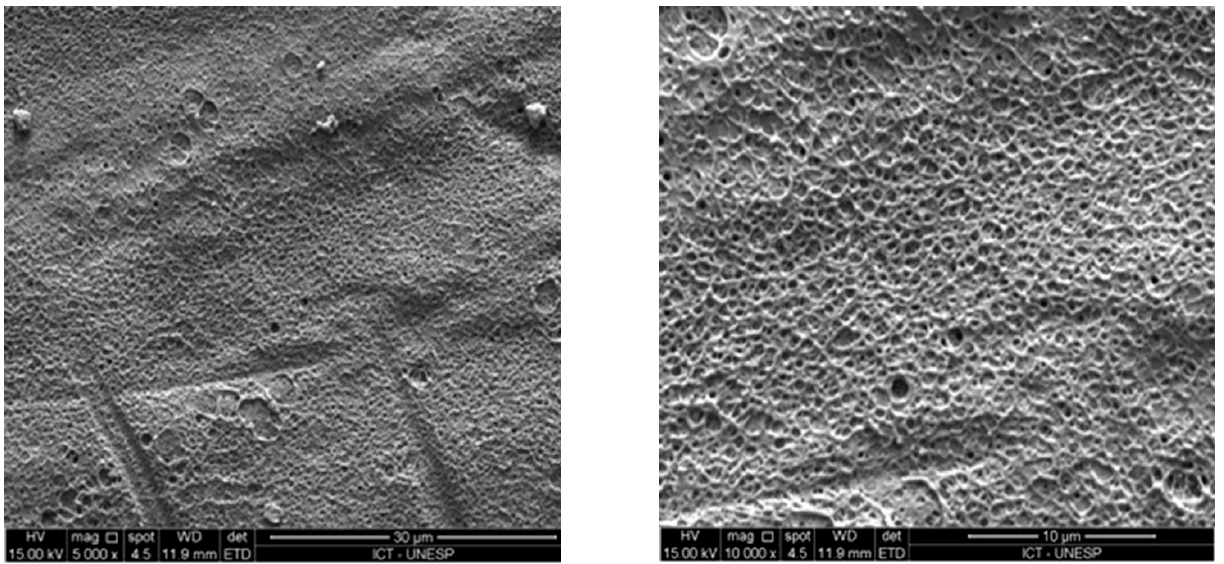
Figure 7. Sulfuric acid group (SA5). Surface etched with 98% sulfuric acid for 5 s, forming three-dimensional pores. It is noted that there is the presence of even deeper grooves from the milling process. Magnification: 5000× and 10,000×.